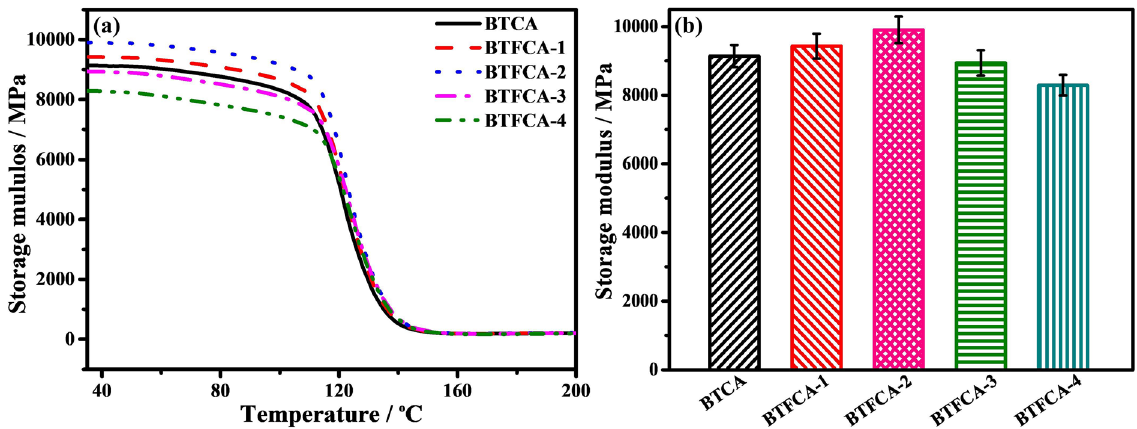
Fig. 7 a DMA curves and b storage modulus of BTCA/epoxy and BTFCA/epoxy